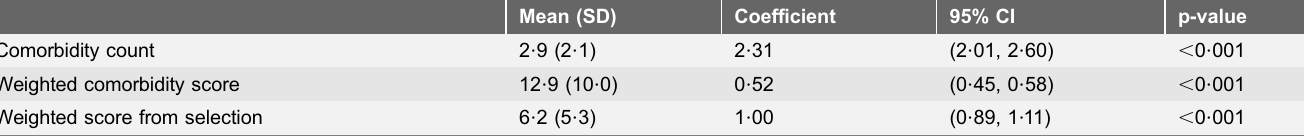
Table 2. Mean, SD and adjusted associations of comorbidity scores and SGRQ value using